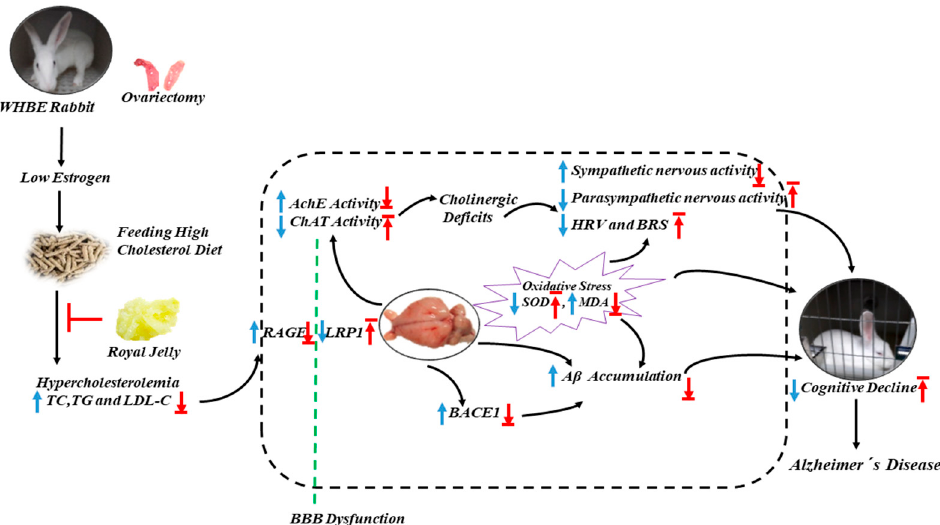
Figure 6. Schematic showing the possible mechanisms by which RJ improves OVX cholesterol-fed rabbits. RJ can reduce blood lipid levels, enhance cholinergic and antioxidant abilities, improve BBB and ANS, down-regulate BACE1 and RAGE expression, increase the expression levels of LRP1, promote the metabolism of A β , and thereby ameliorate behavioral deficits and reduce the susceptibility to AD. TC, total cholesterol; TG, triglycerides; LDL-C, low-density lipoprotein cholesterol; BACE1, β -site APP cleaving enzyme 1; BBB, blood–brain barrier; RAGE, receptor for advanced glycation end products; LRP1, LDL receptor-related protein 1; A β , amyloid β -protein; AchE, Acetylcholinesterase; ChAT, Choline Acetyltransferase; MDA, malondialdehyde; SOD, superoxide dismutase; HRV, heart rate variability; BRS, baroreflex sensitivity. Arrows pointing up or down indicate statistically significant increases or decreases ( P < 0.05). Blue arrows indicate the changes in OVX cholesterol-fed rabbits, while red arrows indicate the treatment effects of RJ.